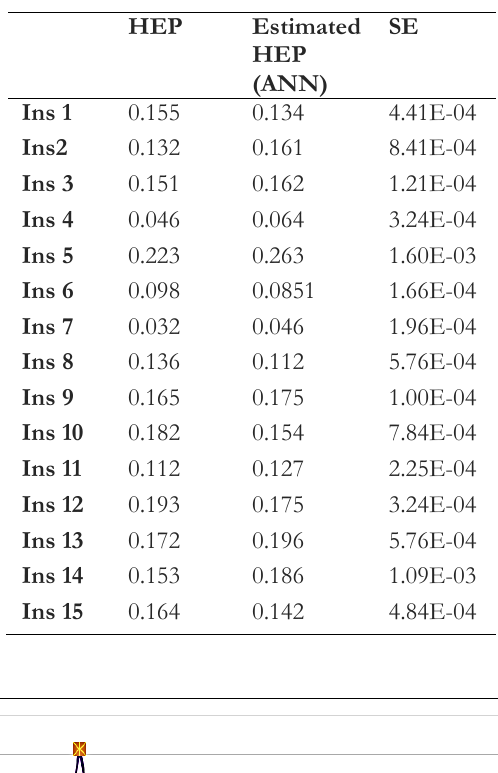
Table 3. The results of ANN.